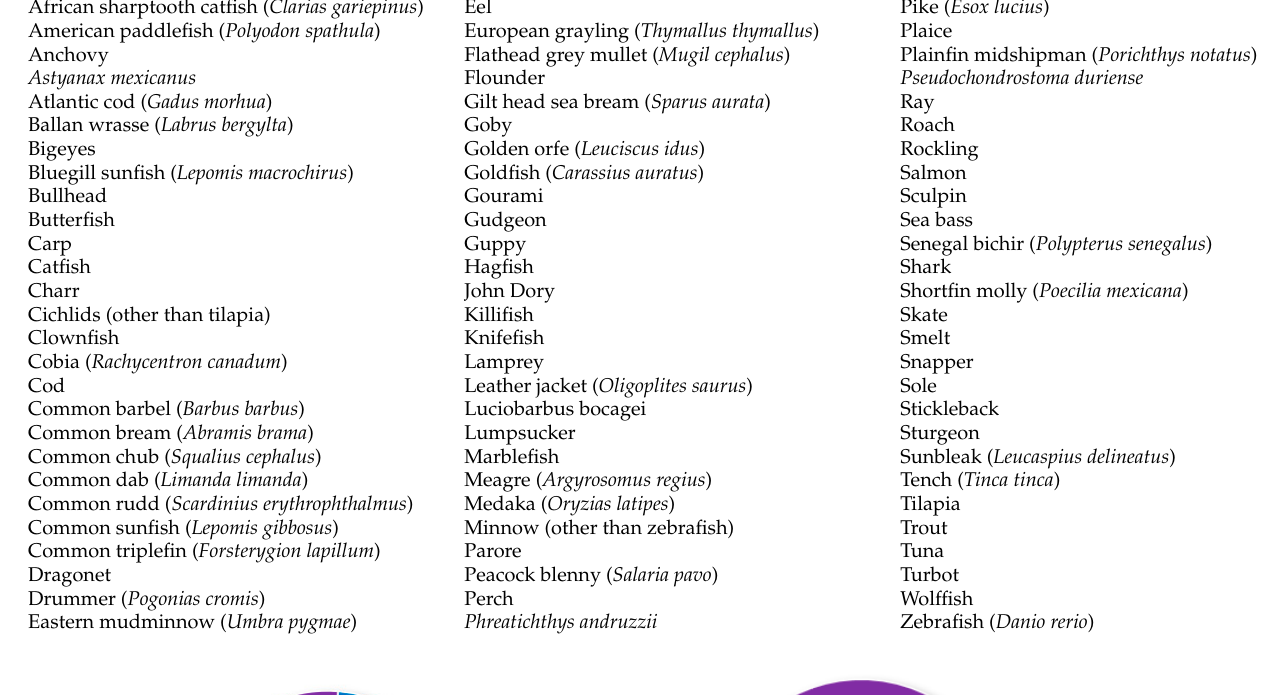
Table 1. List of species and/or groups of fishes used for research by survey participants.